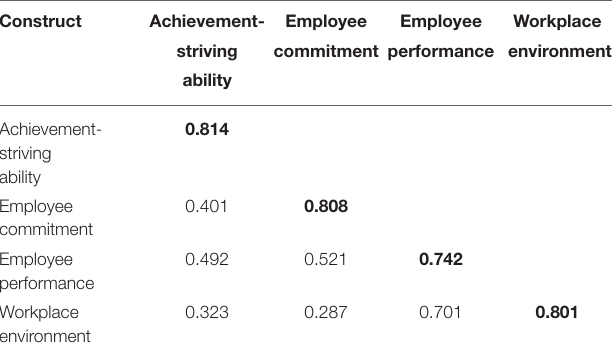
TABLE 3 | Discriminant validity (Fornell–Larker-1981 criteria).